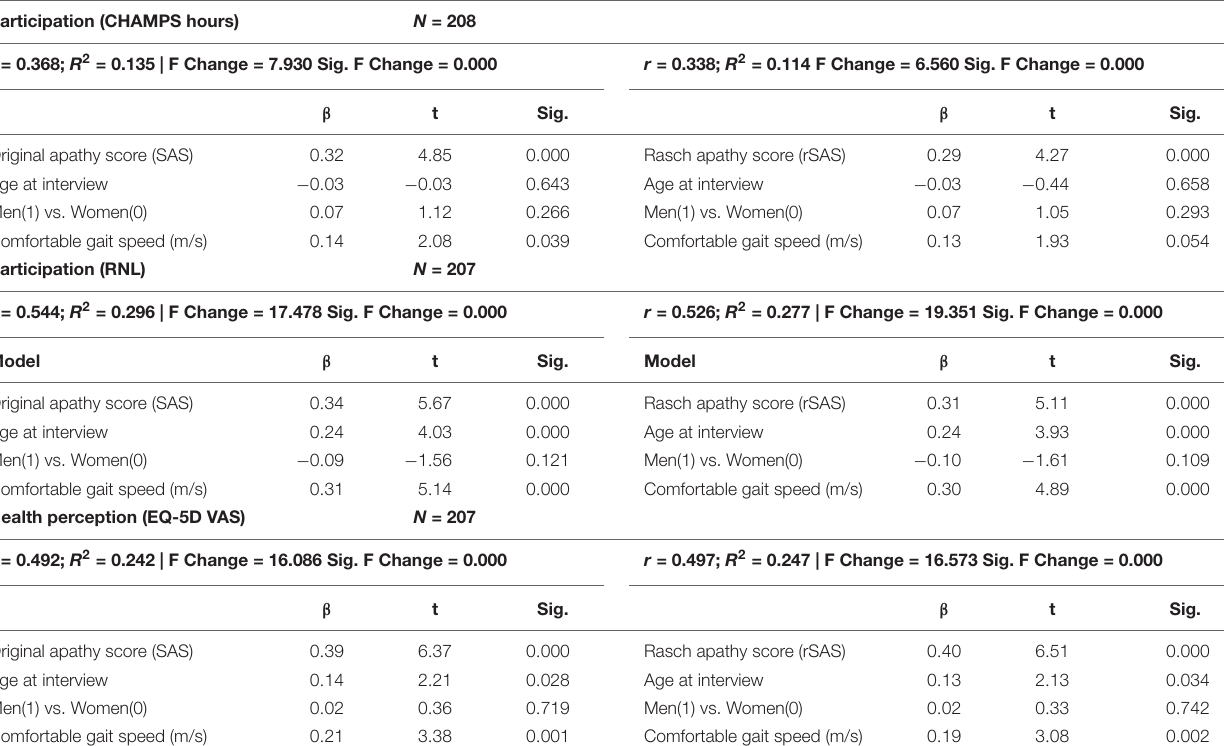
TABLE 5 | Regression of apathy (original total score or Rasch apathy score [rSAS]) as a predictor of downstream outcomes (participation/HRQL). Participation (CHAMPS hours) N = 208